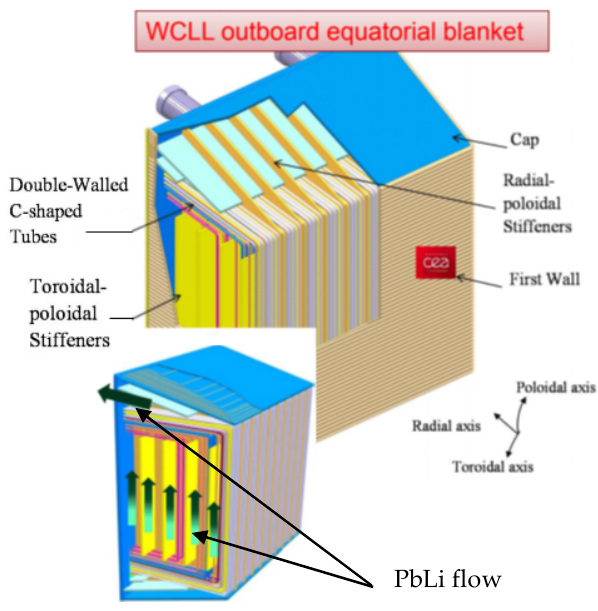
Figure 5. Schematics of the WCLL blanket. Shown is the CEA WCLL design for 2012 EU DEMO [31].